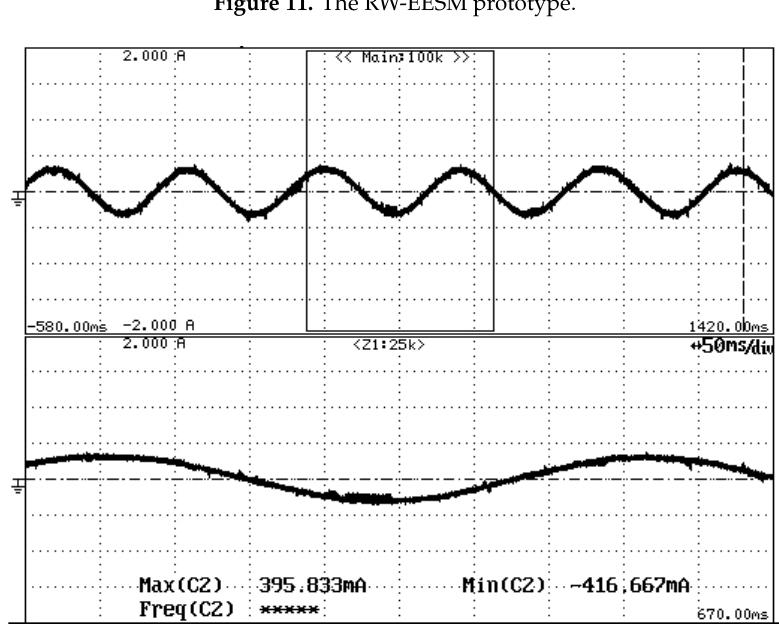
World Electric Vehicle Journal 2019 , 10 , x